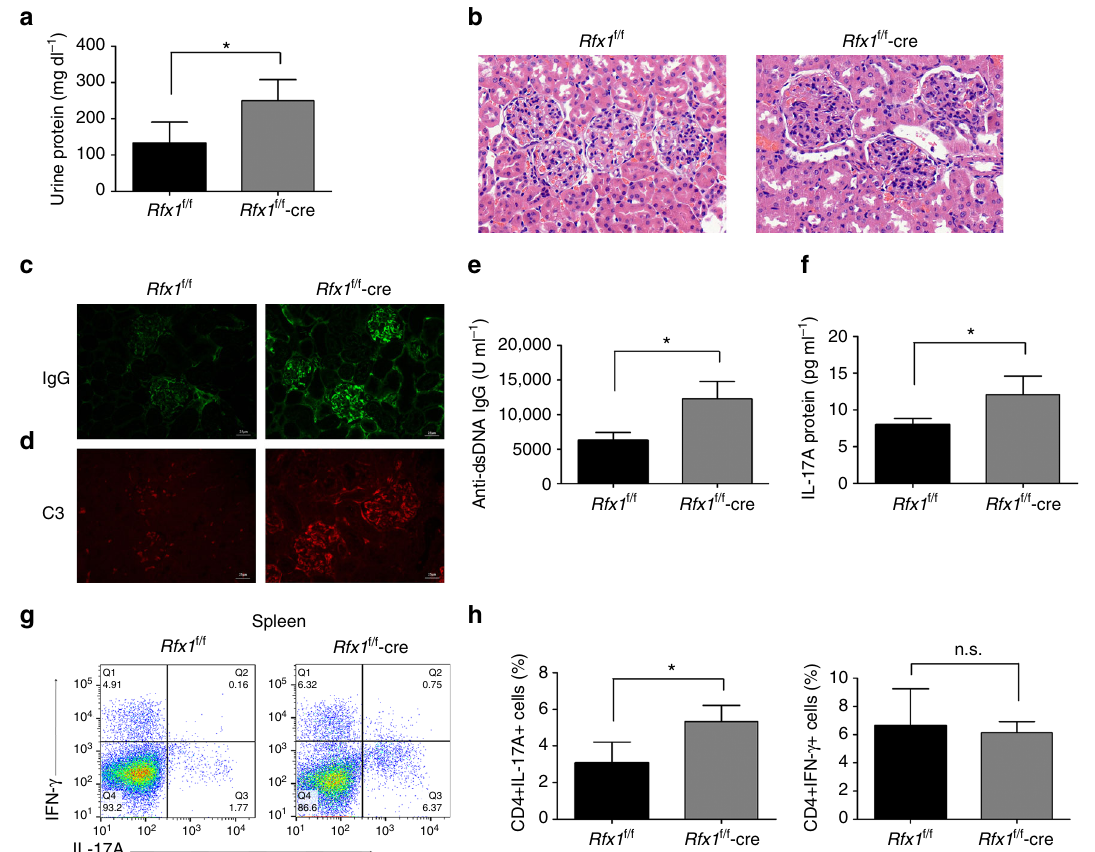
Fig. 7 Rfx1 cKO mice have more severe lupus autoimmunity. Rfx1 f/f -cre ( n = 4) or Rfx1 f/f ( n = 3) mice were injected with 500 μ l of pristane, respectively, as described in Materials and Methods section. Mice were sacri fi ced at 20 weeks after pristane treatment. a Urine protein excretion was measured at the end of the observed period. b Representative images of hematoxylin and eosin-stained sections of kidneys collected at the end of observed period are shown (magni fi cation ×400). IgG ( c ) and C3 ( d ) depositions in the kidney sections were assessed by immuno fl uorescence. Scale bar, 25 μ m. Serum anti-dsDNA IgG ( e ) and IL-17A protein ( f ) were quanti fi ed by ELISA. g , h Flow cytometric analysis of the percentages of CD4 + IL-17A + T cells and CD4 + IFN- γ + T cells in the spleens of Rfx1 f/f -cre mice and Rfx1 f/f mice were evaluated by fl ow cytometry. Data are shown as mean ± s.d. * P < 0.05; n.s., not signi fi cant, two-tailed Student ’ s t Rfx1 de fi ciency exacerbates lupus disease . To further test whe- ther Rfx1 de fi ciency exacerbates lupus disease, Rfx1 f/f -cre mice and Rfx1 f/f control mice were injected with pristane to induce lupus-like model and observed for 5 months. At the end of the observation period, urinalysis showed that Rfx1 f/f -cre mice had a higher proteinuria level compared to Rfx1 f/f control mice